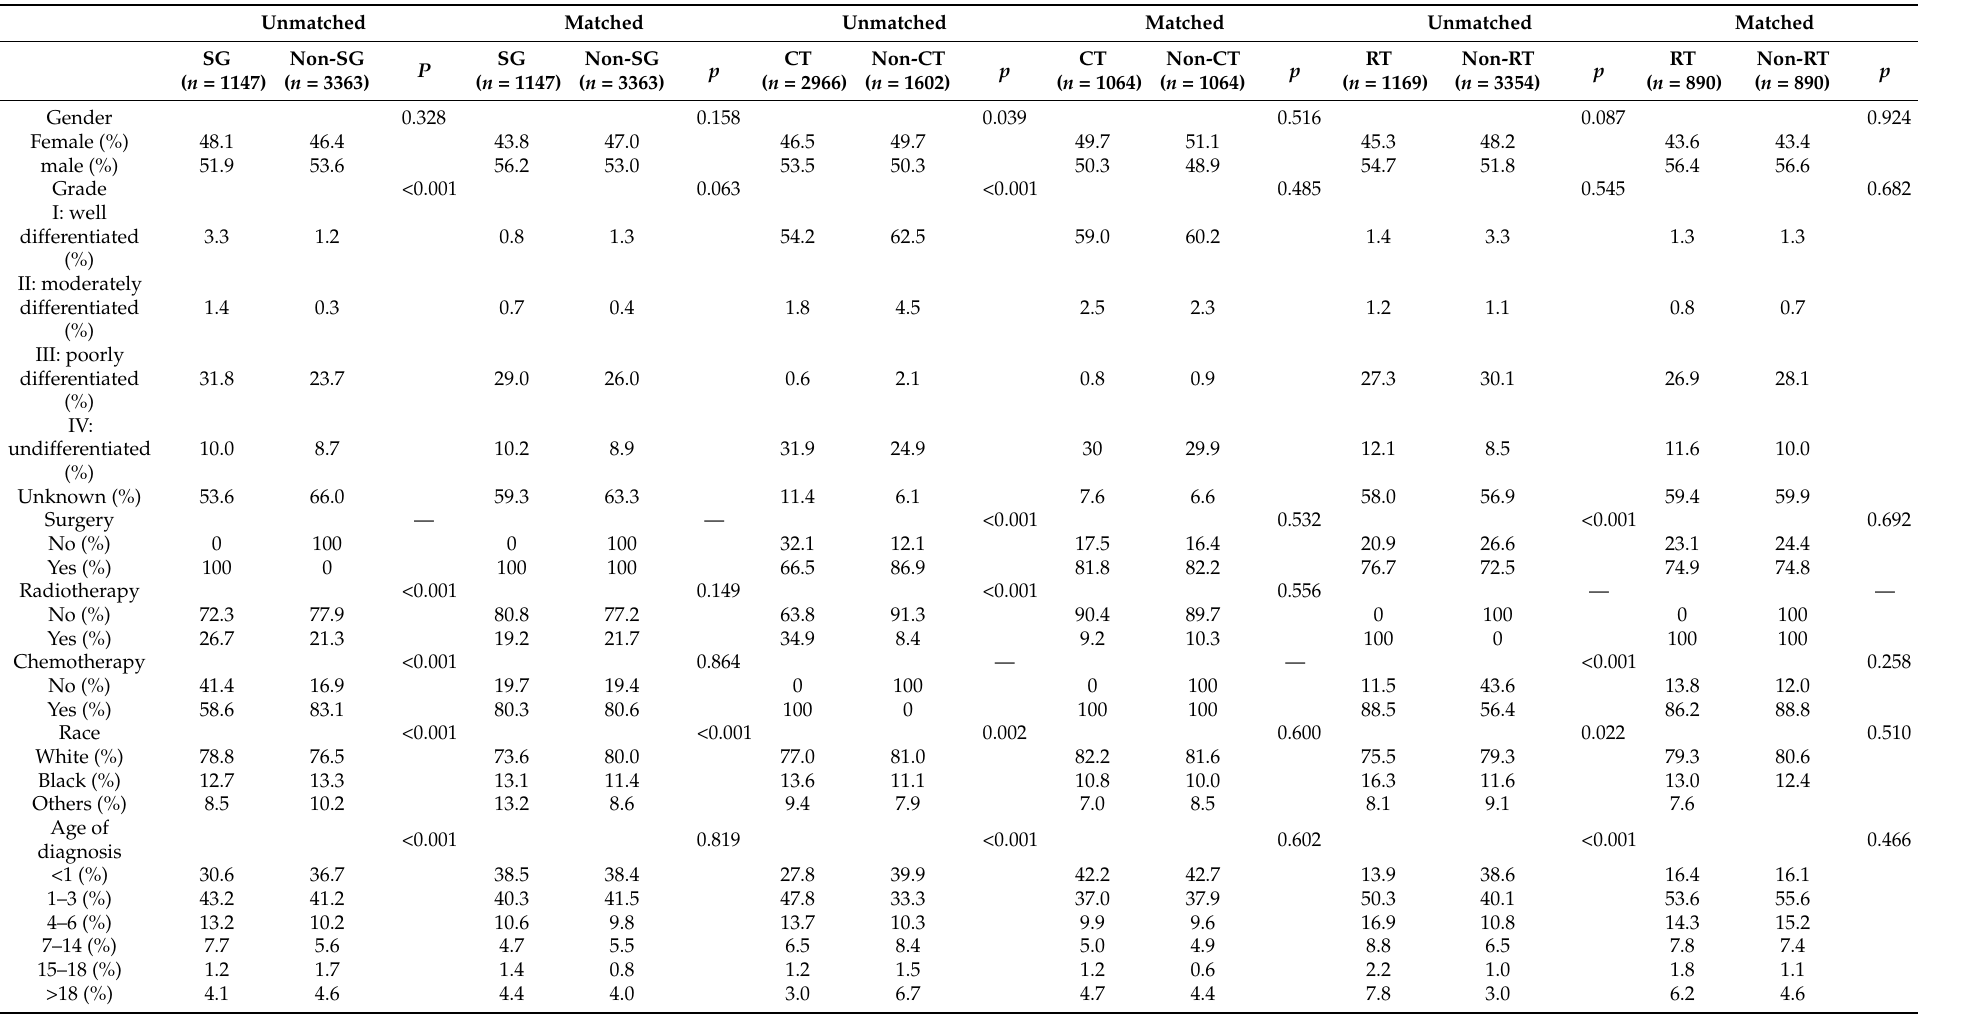
Table 1. Baseline characteristics before and after matching according to whether the patients received surgery, chemotherapy or radiation therapy. Unmatched Matched Unmatched Matched